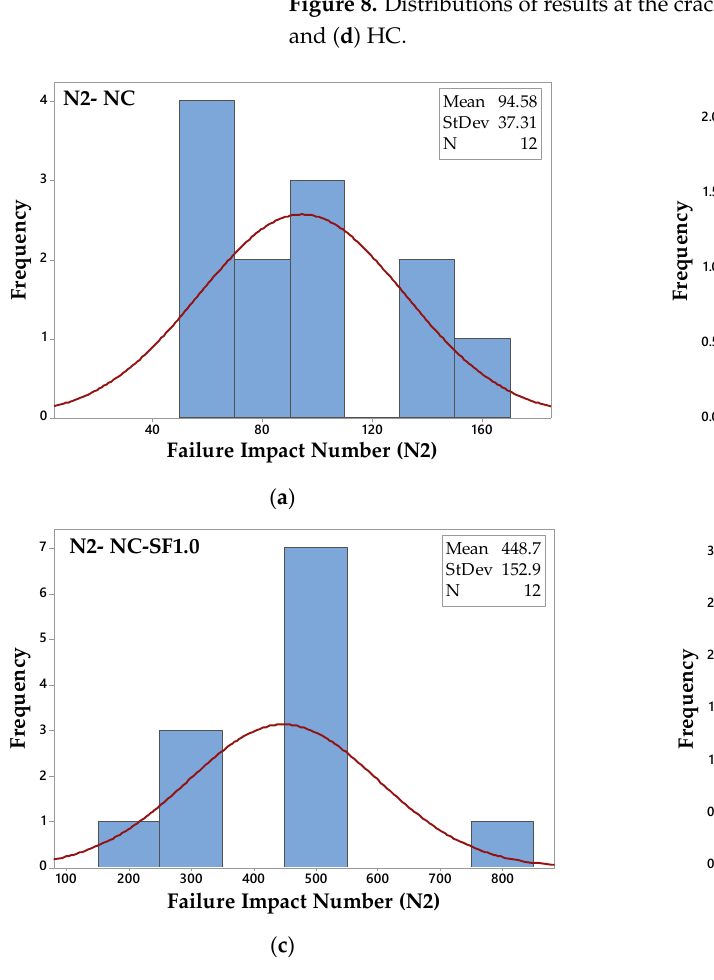
Figure 9. Distribution of results at the failure stage for mixtures ( a ) NC ( b ) NC-SF0.5 ( c ) NC-SF1.0 and ( d ) HC.